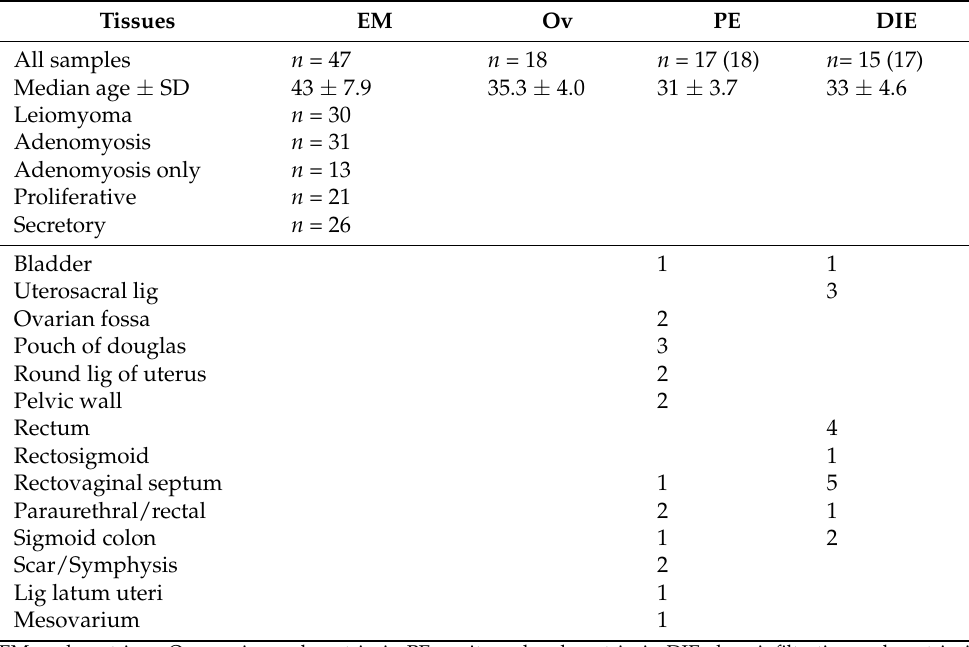
Table 2. Overview of the tissue samples used for